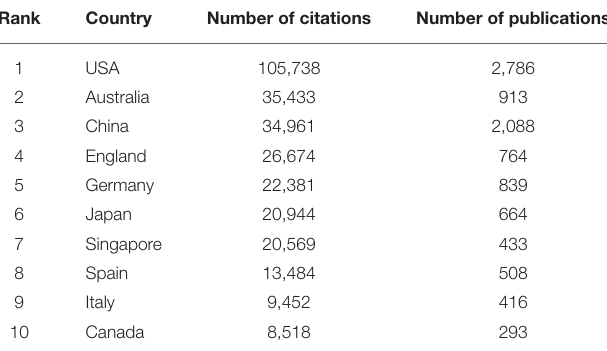
TABLE 1 | Top 10 most influential countries in myopia